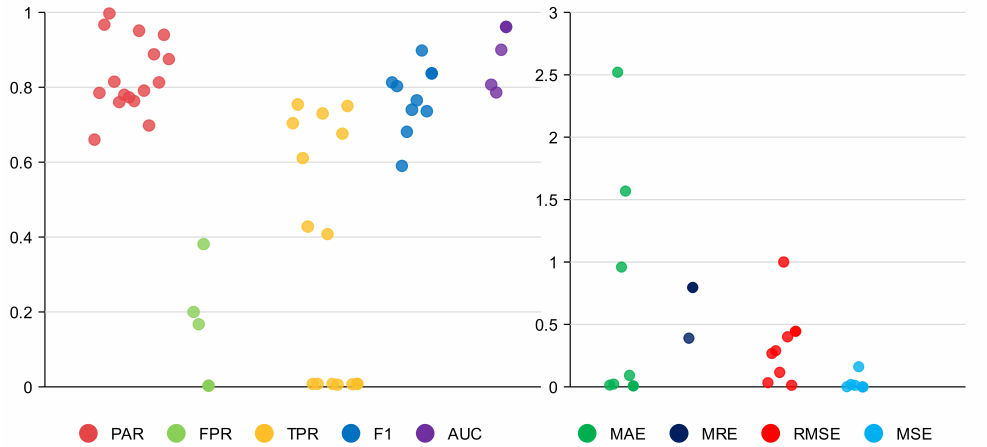
Figure 3. Dispersion of values of evaluation